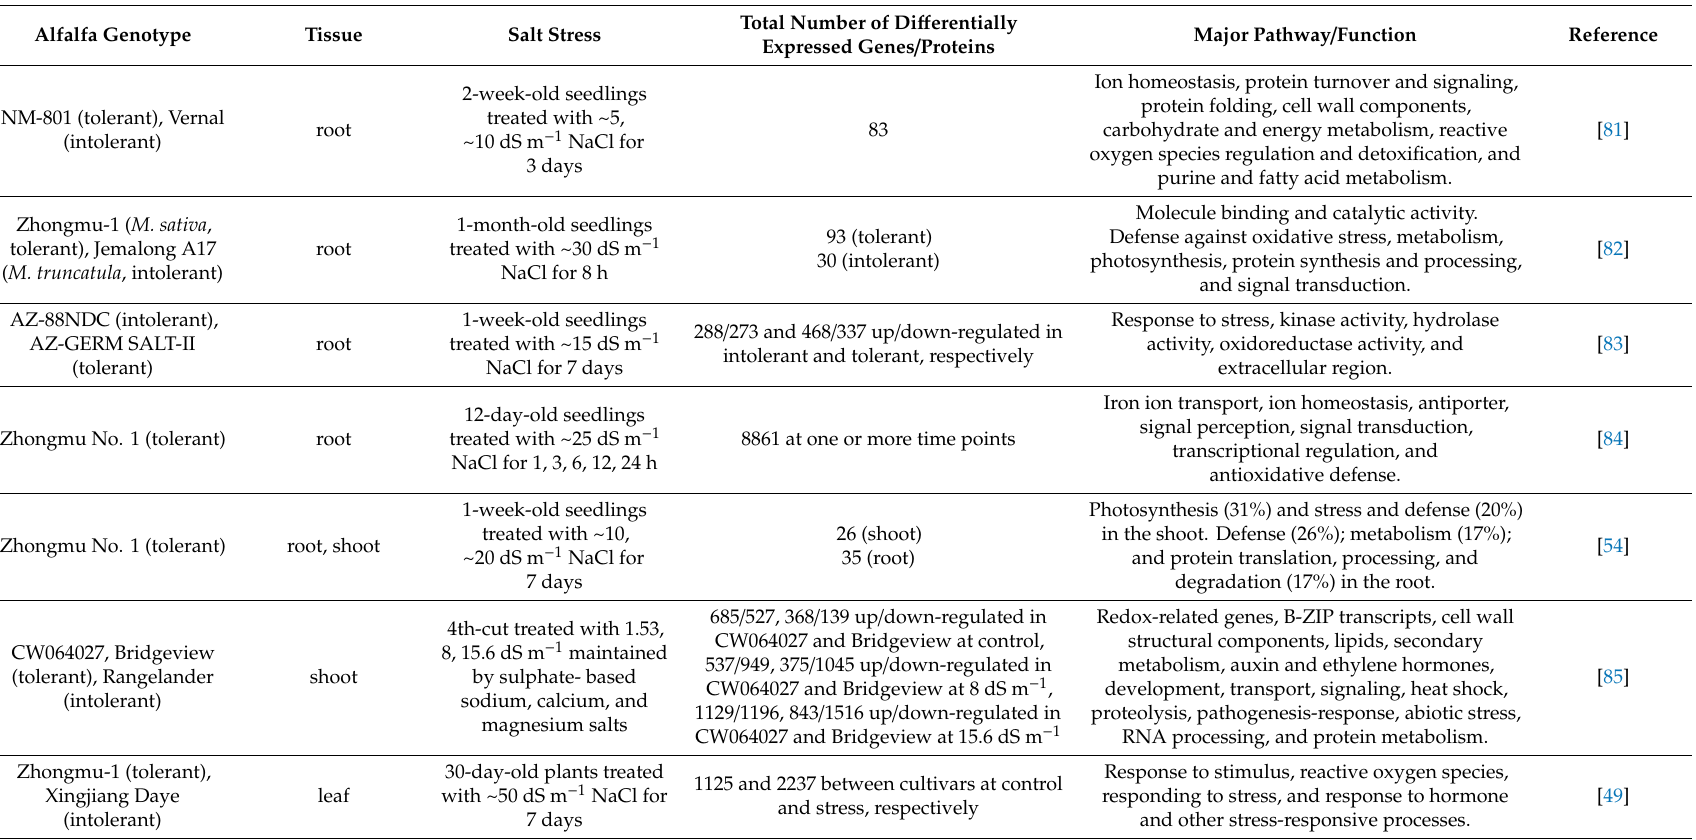
Table 1. Number of di ff erently expressed genes and proteins and their functions in salt-tolerant and intolerant alfalfa cultivars. Total Number of Di ff erentially Alfalfa Genotype Tissue Salt Stress Major Pathway / Function Expressed Genes / Proteins